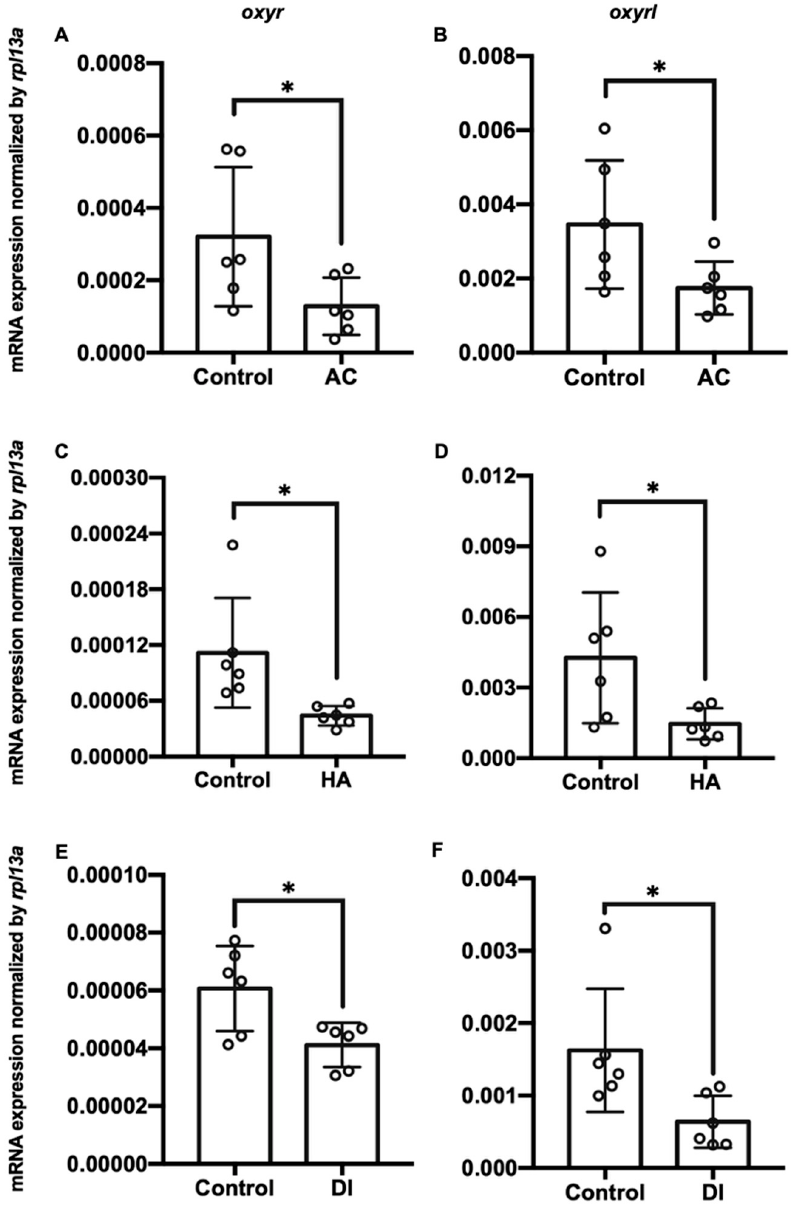
Figure 2. Charts showing mRNA expression of oxyr and oxyrl in the gills of adult zebrafish acclimated to ( A , B ) acidic (AC), ( C , D ) high-ammonia (HA), or ( E , F ) double-deionized (DI) water for 7 days. Rpl13a was used as an internal control to normalize relative expression. Each circle represents the data of one single fish. The asterisks (*) indicate significant differences between the control and treatment groups. Values are means ± SD ( n = 6, p < 0.05 (Student’s t -test)).